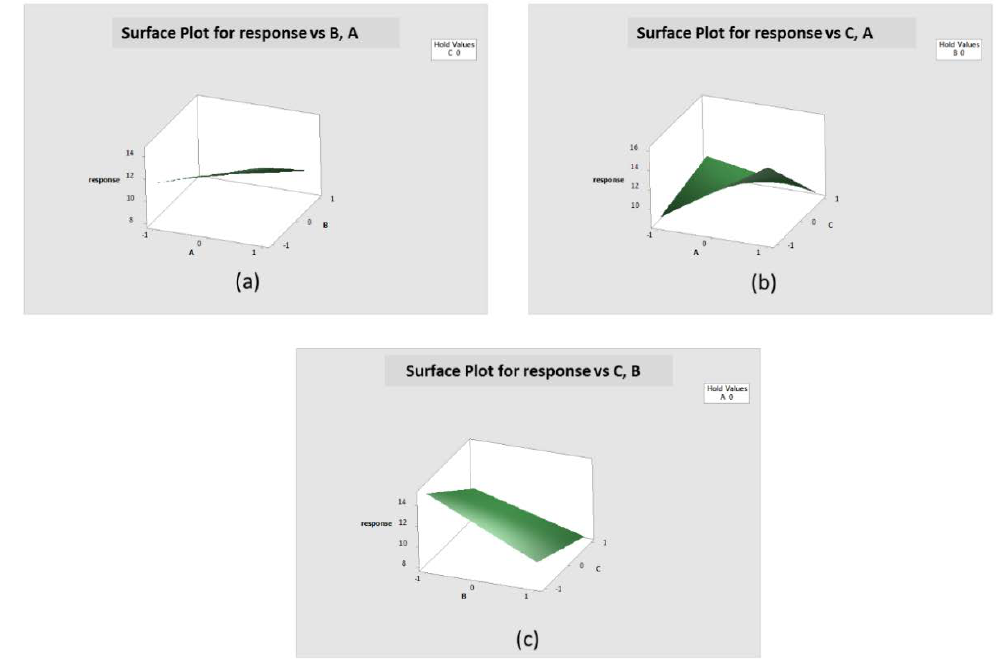
Figure A18. Surface plots for different variable vs. response (A = power, B = speed, C = thickness). ( a ) . Plot for response vs B, A ( b ) . Plot for response vs C, A ( c ) . Plot for response vs C, B